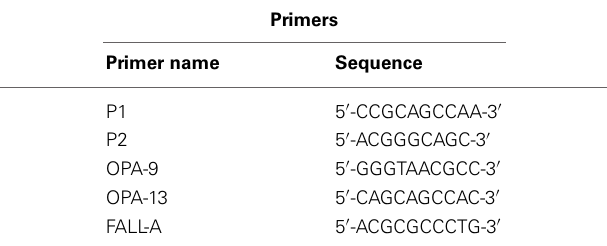
Table 3 | Random primers for genomic